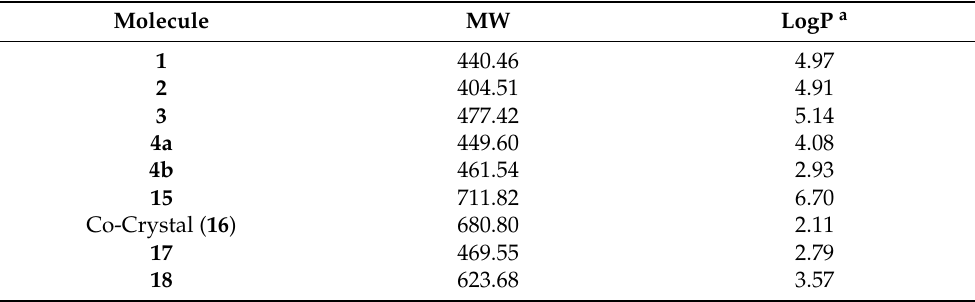
Table 3. Computed LogP values and molecular weight (MW) for the studied